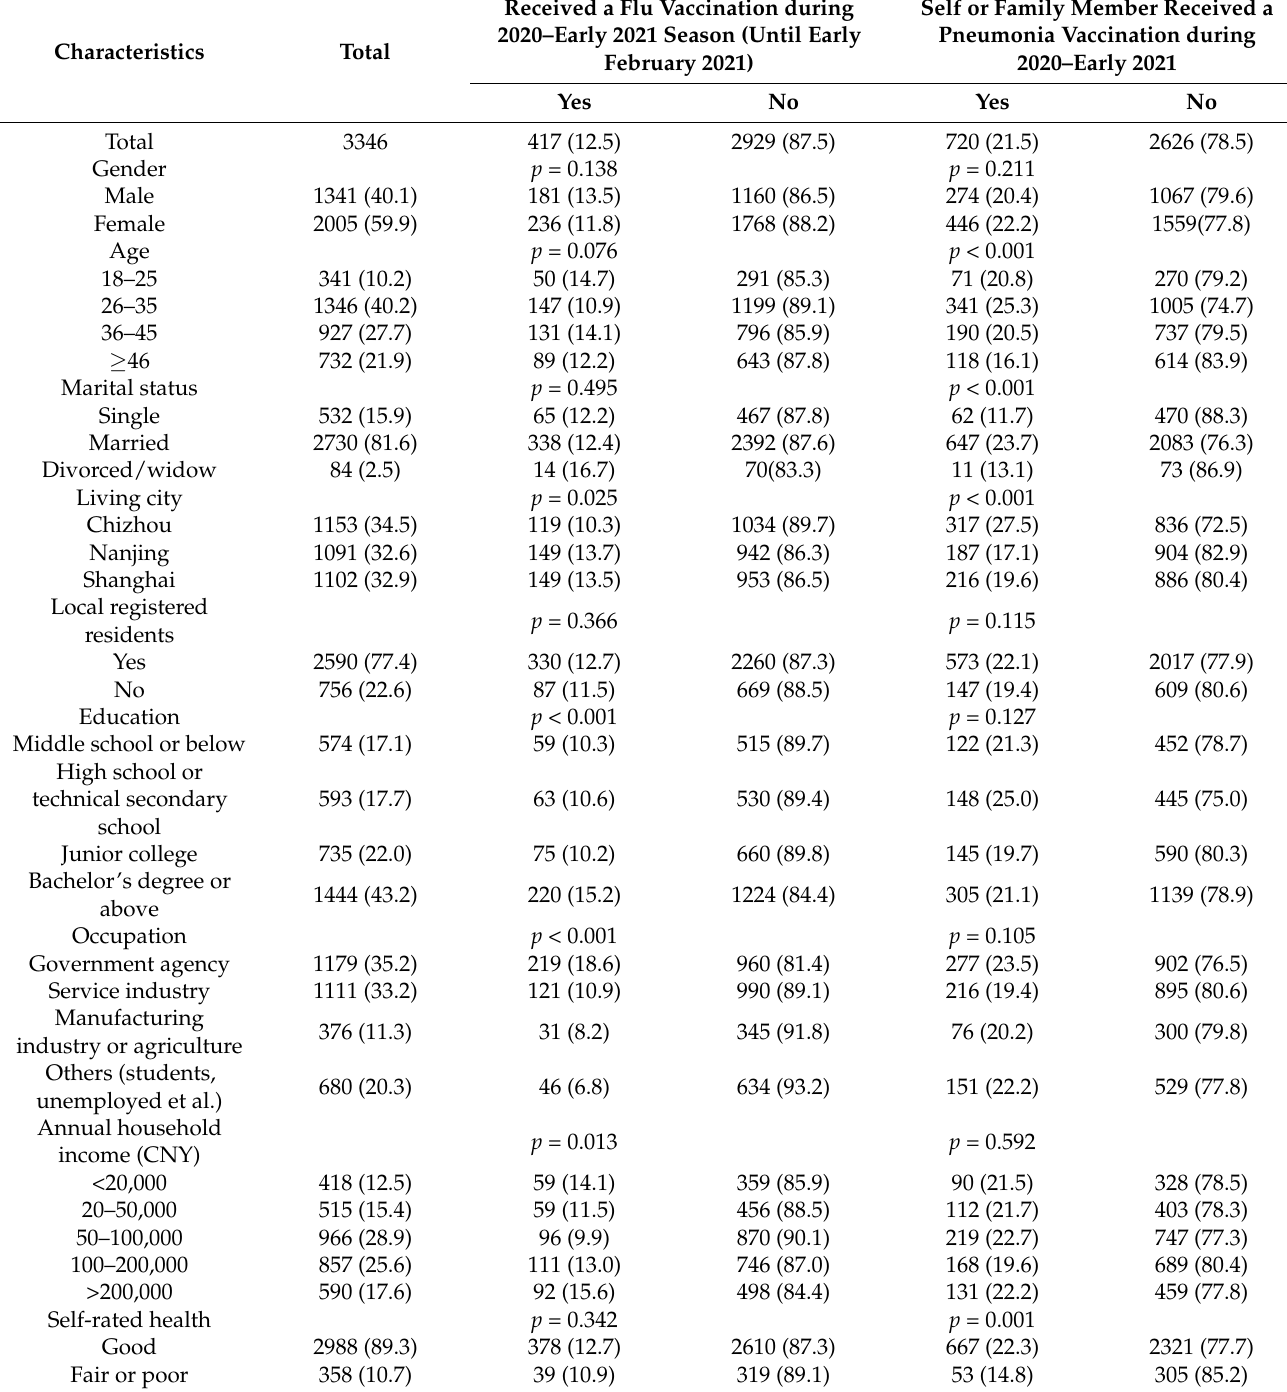
Table 1. Univariable analysis of the respondents’ characteristics and their flu/pneumonia vaccination status. n (%).